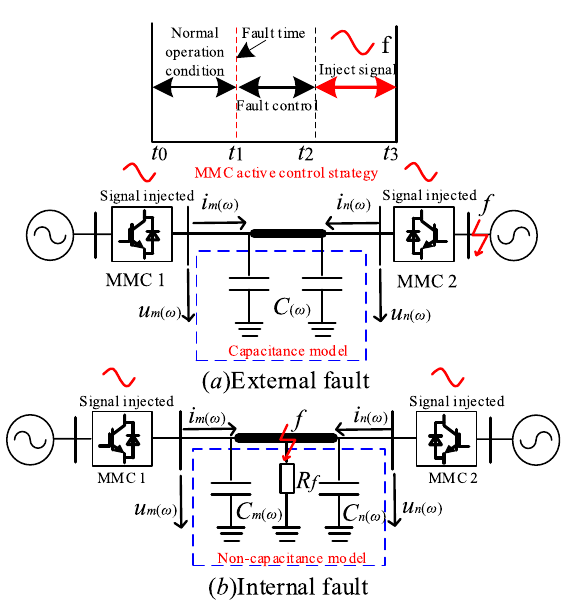
Fig. 3 Block diagram of active pilot